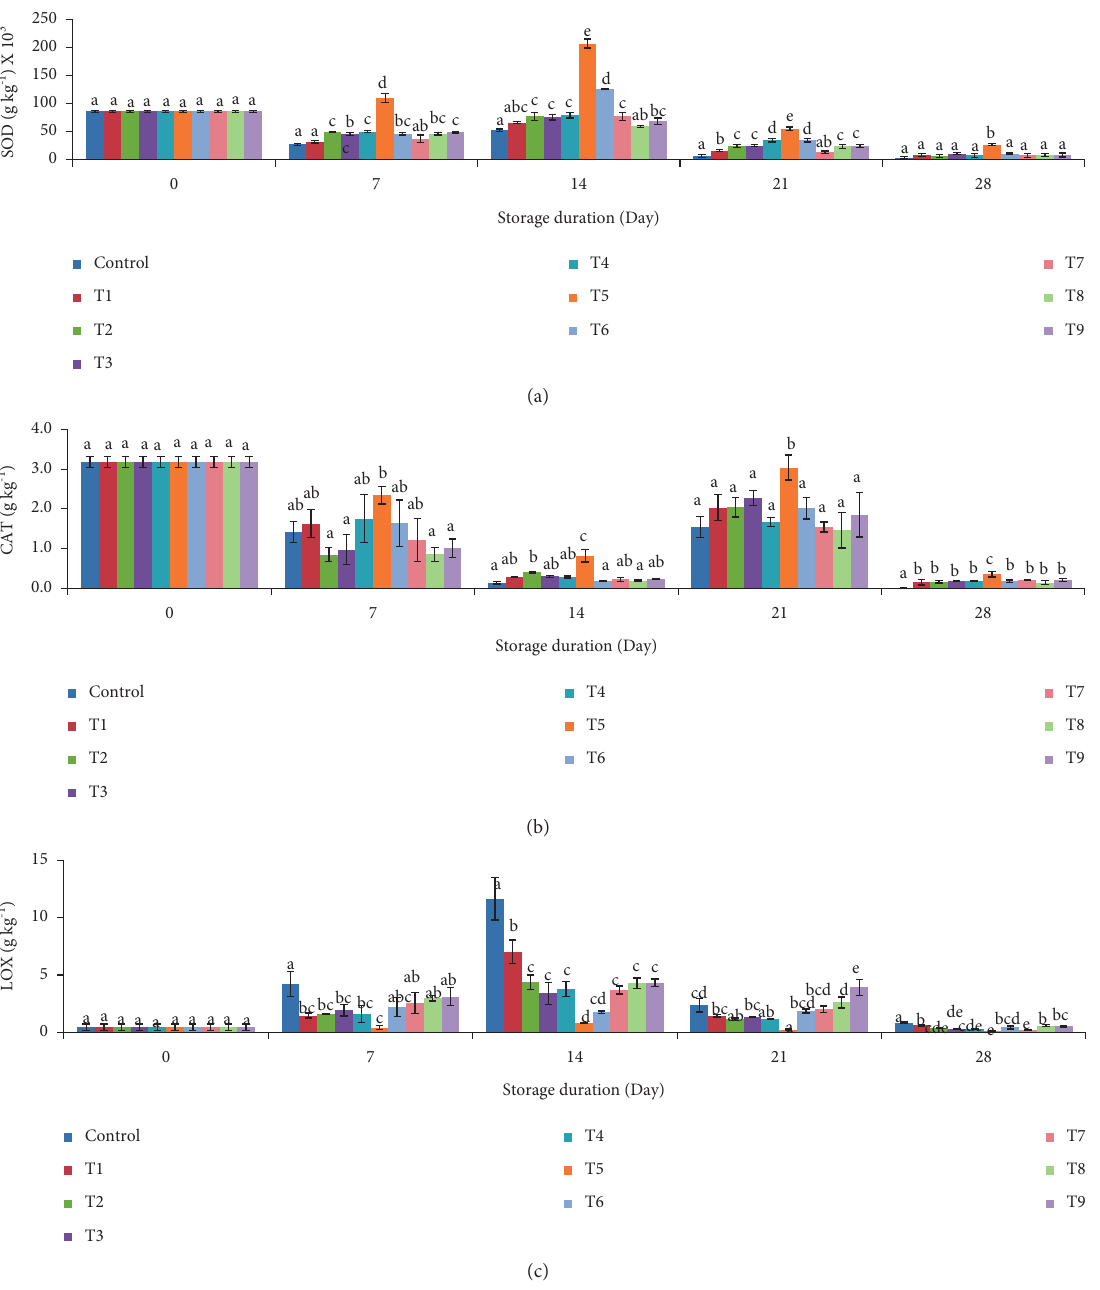
Figure 5: (a) Superoxide dismutase (SOD), (b) catalase (CAT), and (c) lipoxygenase (LOX) activities of mango cv. “Dashehari” treated with melatonin (MT), followed by low-temperature storage at 5 ± 1 ° C. Measurements were taken every 7 d of storage, followed by a 3d of shelf life at room temperature. Each value is the mean of three replicates; vertical bars indicate the standard error. Different lowercase letters on the same storage period indicate a significant difference ( p < 0 . 05) according to Duncan’s multiple range test. The abbreviated treatment details: 0 (control), 50 µ M for 90min (T1), 50 µ M for 120 min (T2), 50 µ M for 150min (T3), 100 µ M for 90min (T4), 100 µ M for 120min (T5), 100 µ M for 150min (T6), 150 µ M for 90min (T7), 150 µ M for 120min (T8), and 150 µ M for 150min